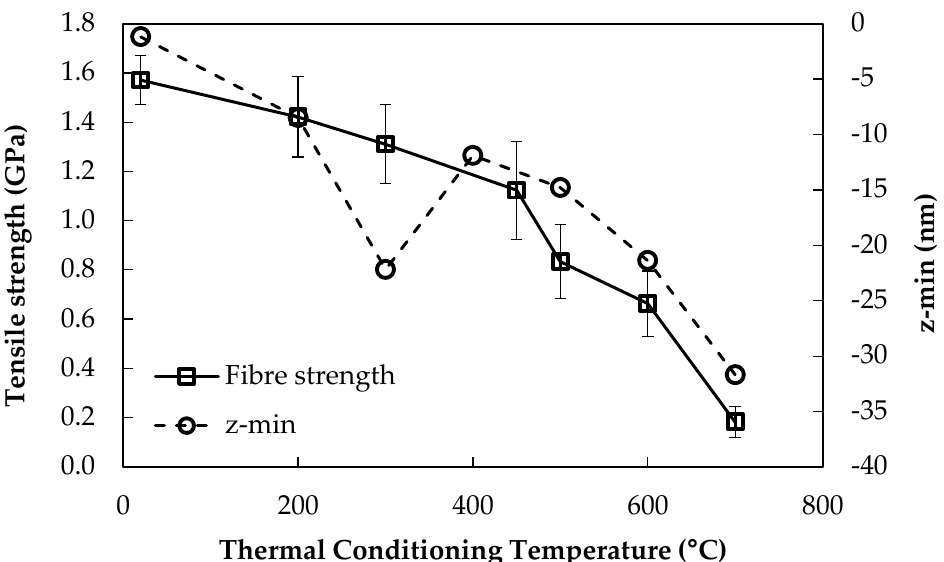
Figure 5. Average fibre tensile strength at room temperature, and average minimum topographical feature in the z-direction after thermal conditioning.